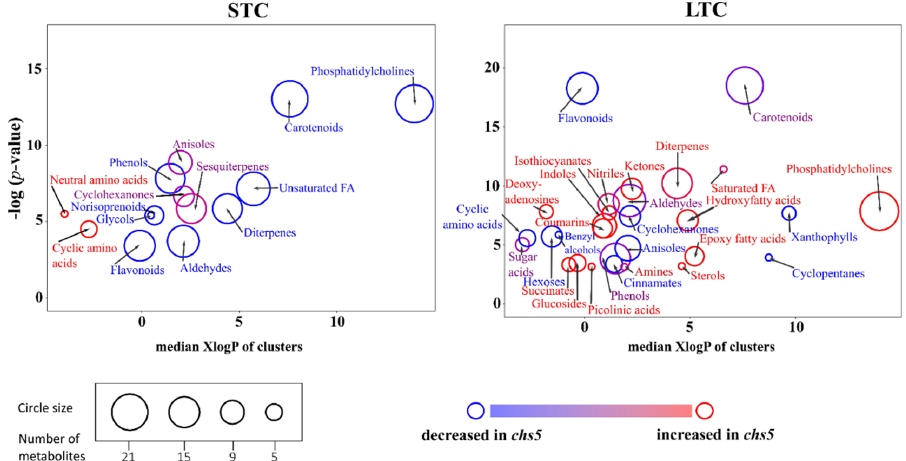
Figure 2. Chemical similarity enrichment analysis (ChemRICH) of metabolic profiles. Each circle represents a significantly altered family of metabolites (cluster). These clusters are defined based on chemical similarities highlighted by a hierarchical Tanimoto map (not shown). The plot y ‐ axis shows